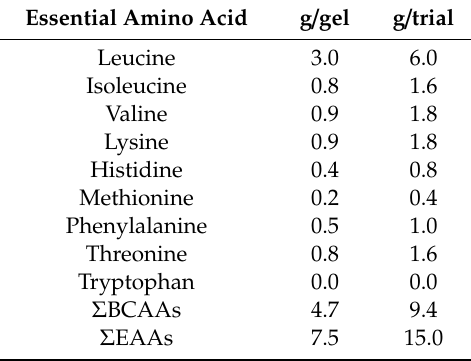
Table 2. Essential amino acid composition of the gels (50 mL each) used in the EAA and COM trials. Essential Amino Acid g / gel g / trial